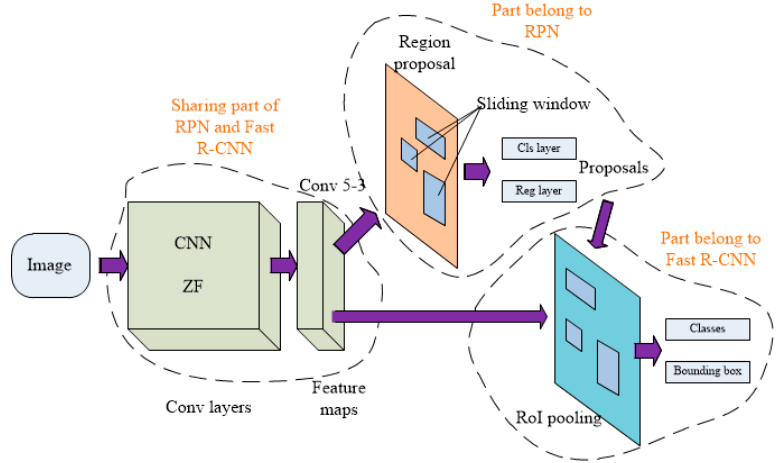
Figure 5. The Faster R-CNN model.